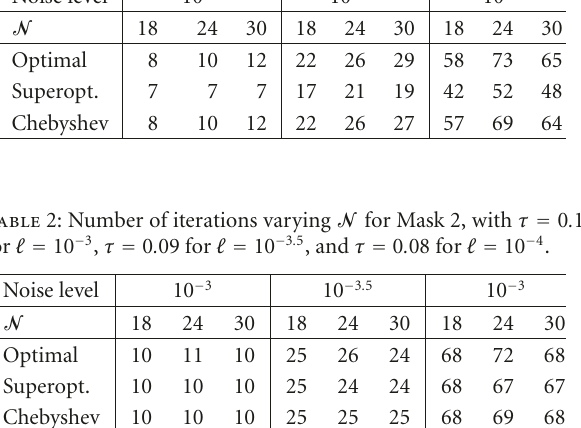
Table 1: Number of iterations varying N for Mask 1, with τ = 0 . 07